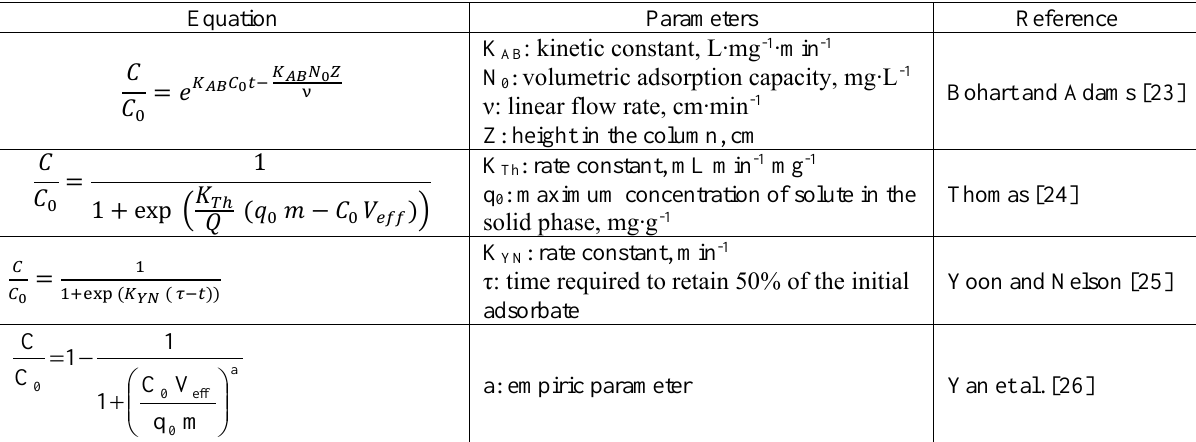
Table 3: Summary of the equations of the kinetic models applied in this work for describing phenol adsorption onto SBFA in a fixed-bed column.